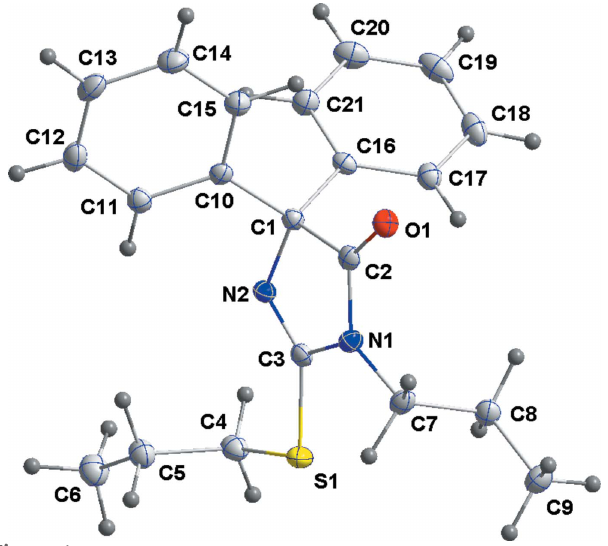
Figure 1 The title molecule with the atom-labelling scheme and 50% probability ellipsoids.